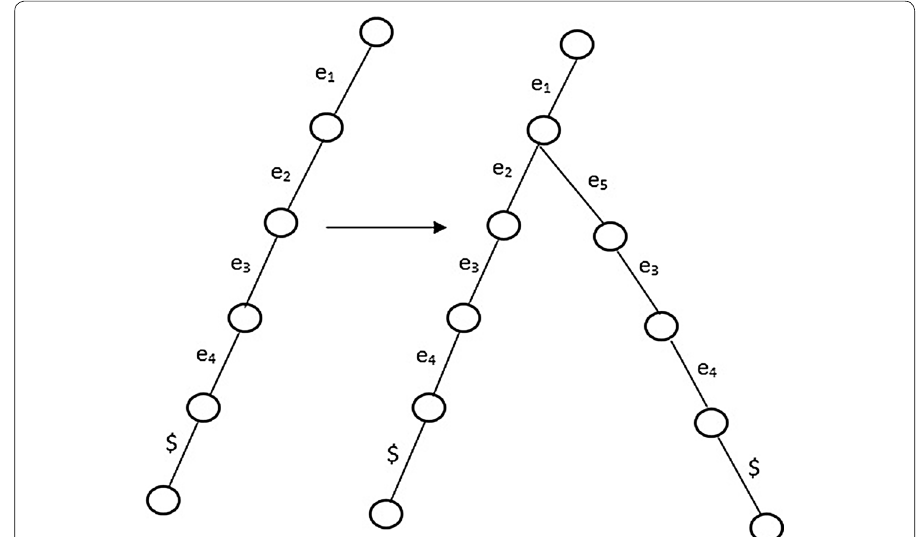
Fig. 4 String e1, e2, e3, e4, $ inserted in an empty tree then string e1, e5, e3, e4, $